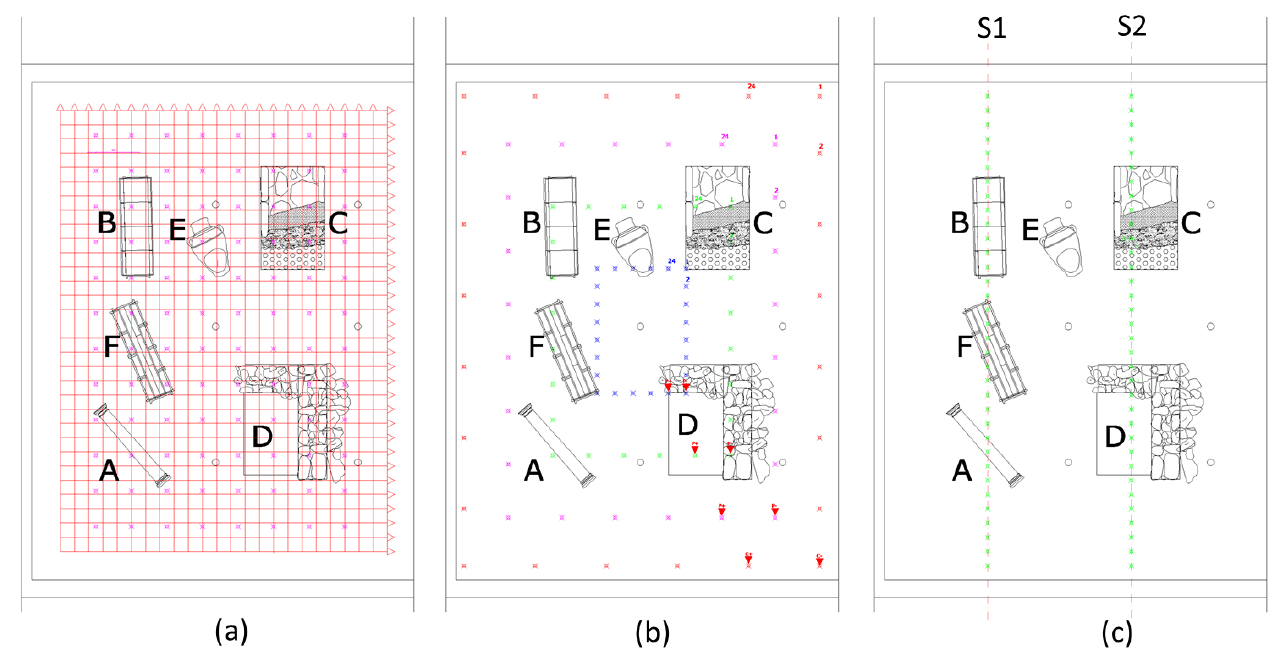
Figure 5. Acquisition grid used to collect GPR data and the location of the electrodes for dipole–dipole acquisition in WP1: ( a ) the red arrows indicate the GPR acquisition direction, while the coloured circles individuate the position of the electrodes; ( b ) the loop–loop 3D ERT was defined with the electrodes located along four loops with different electrode distances; ( c ) the lines investigated with the GPR and ERT in WP2, the green circles indicate the position of the